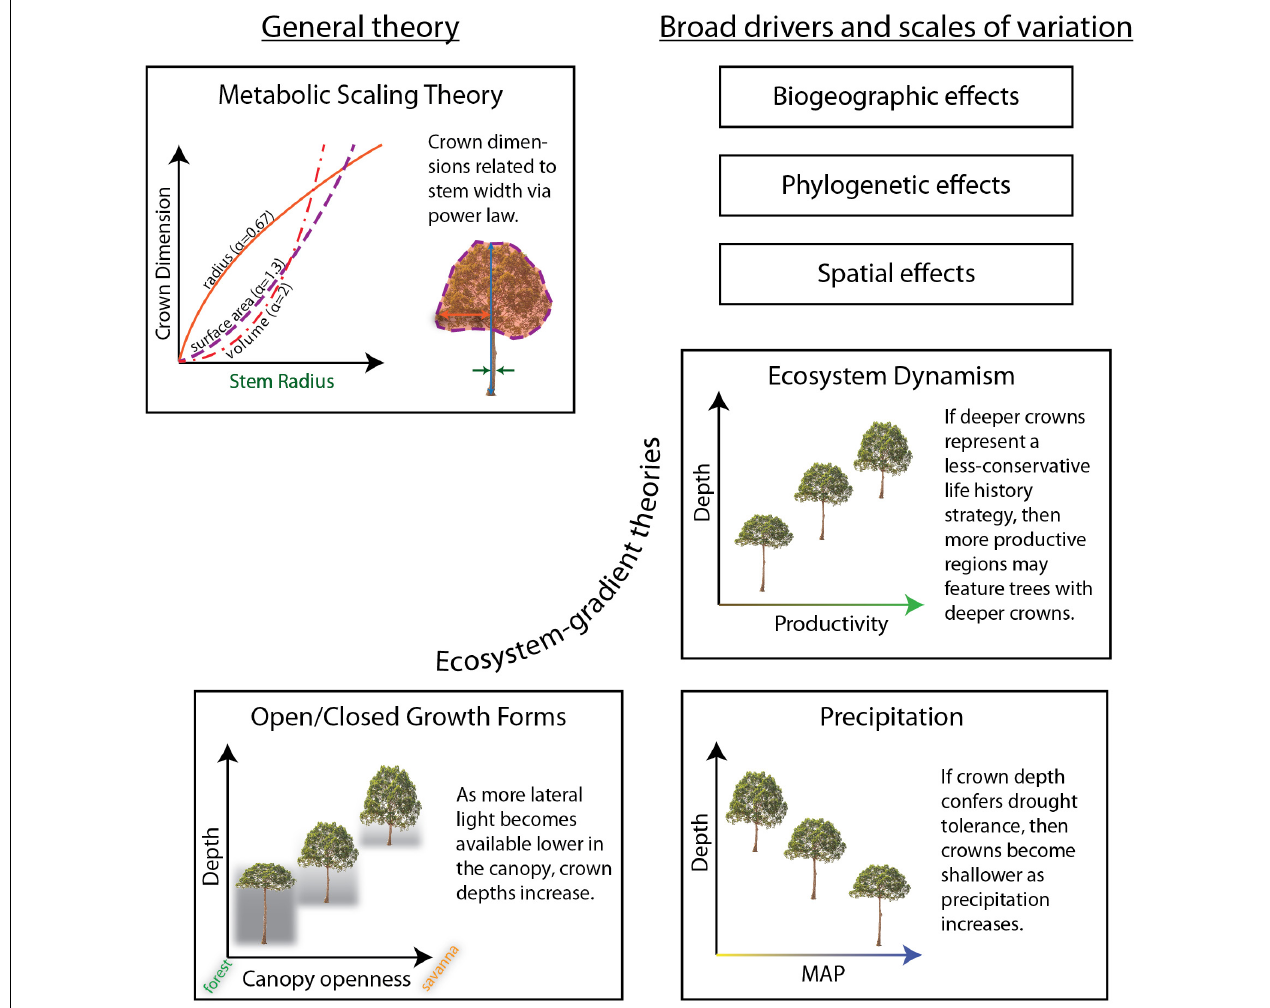
FIGURE 1 | Hypotheses explaining aspects of crown size and shape tested in this study. The ecosystem-gradient hypotheses all refer to trees of equivalent sizes (i.e., stem radius and/or tree height). Results are summarized in Table 1 .